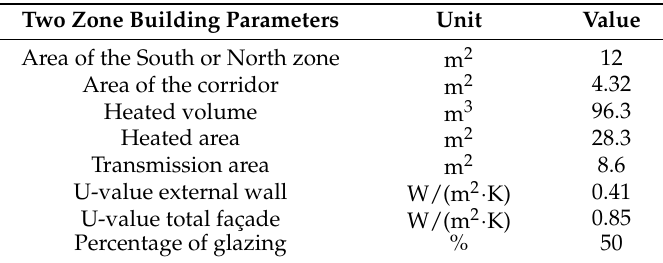
Table 2. Module characteristics.